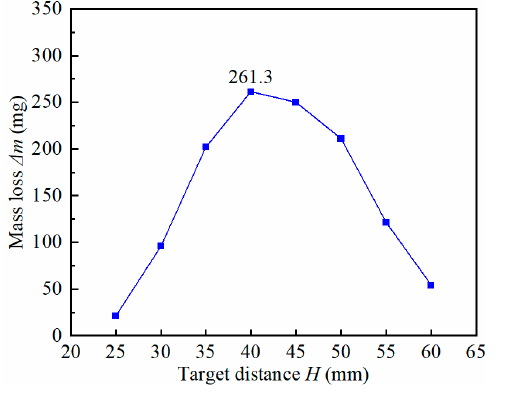
( b ) Figure 8. Dimensionless instantaneous cavitation intensity obtained by image processing: ( a ) at a